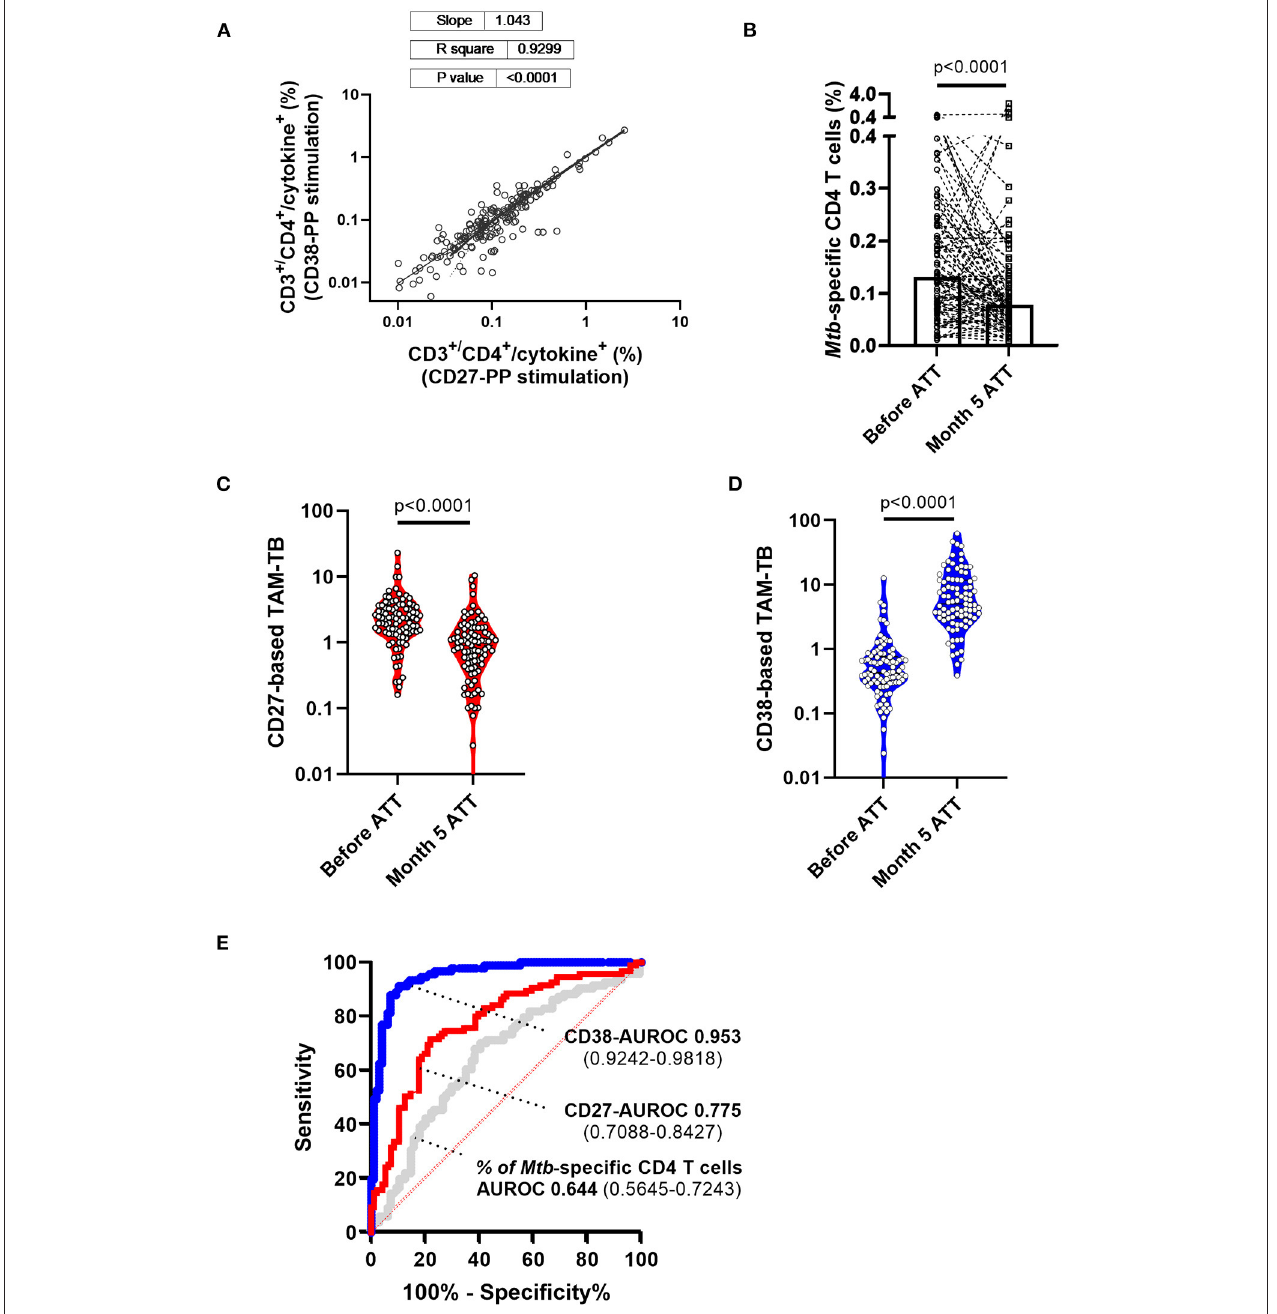
FIGURE 3 | Superiority of CD38- over CD27-based T cell activation marker to attest TB infection resolution following 5 months of anti-tuberculous treatment. (A) Frequencies within CD3 + /CD4 + cells of cytokine-producing cells across independent stimulation of peripheral blood mononuclear cells from the same patient and for both study visits i.e., before and after 5 months of anti-tuberculosis treatment (ATT). (B) Patient (lines) and median (box) response of the frequencies of antigen-specific T cells recalled by the synthetic peptide pool before and after 5 months of ATT (Month 5 ATT). Evolution of (C) CD27 and (D) CD38T cell activation markers expressed by Mtb -specific CD4T cell before and after 5 months of antibiotic treatment. (E) Receiver operating characteristic (ROC) curve and area under the ROC curve with 95% confidence interval showing the superior discriminatory power (Bootstrap test for two correlated ROC curves, p = 4.919e-06) of CD38- (blue curve) over CD27 (red curve) biomarkers to discriminate Mtb -specific CD4T cell responses of patients before and after 5 months of chemotherapy. In comparison, the AUROC analysis of the variation of Mtb -specific CD4T cell frequency alone (gray curve) before and after ATT displays substantially poorer accuracy.